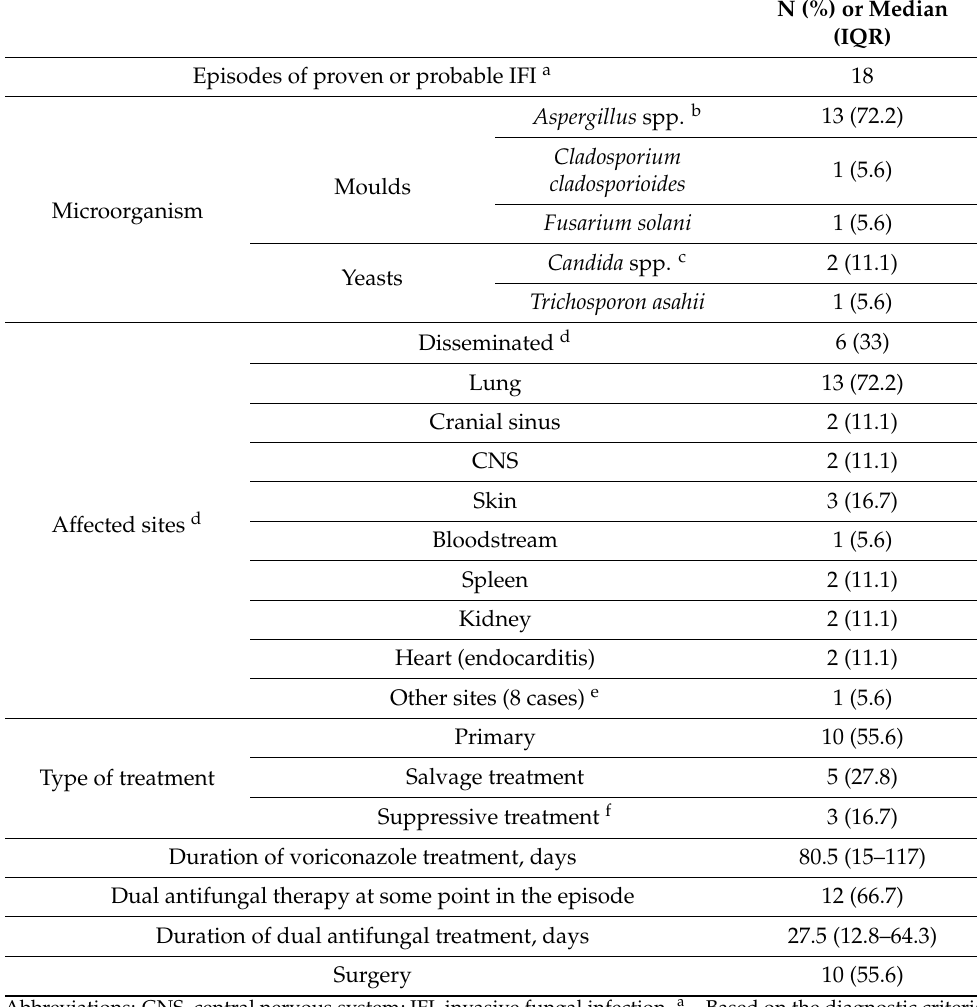
Table 2. Characteristics of proven or probable IFI